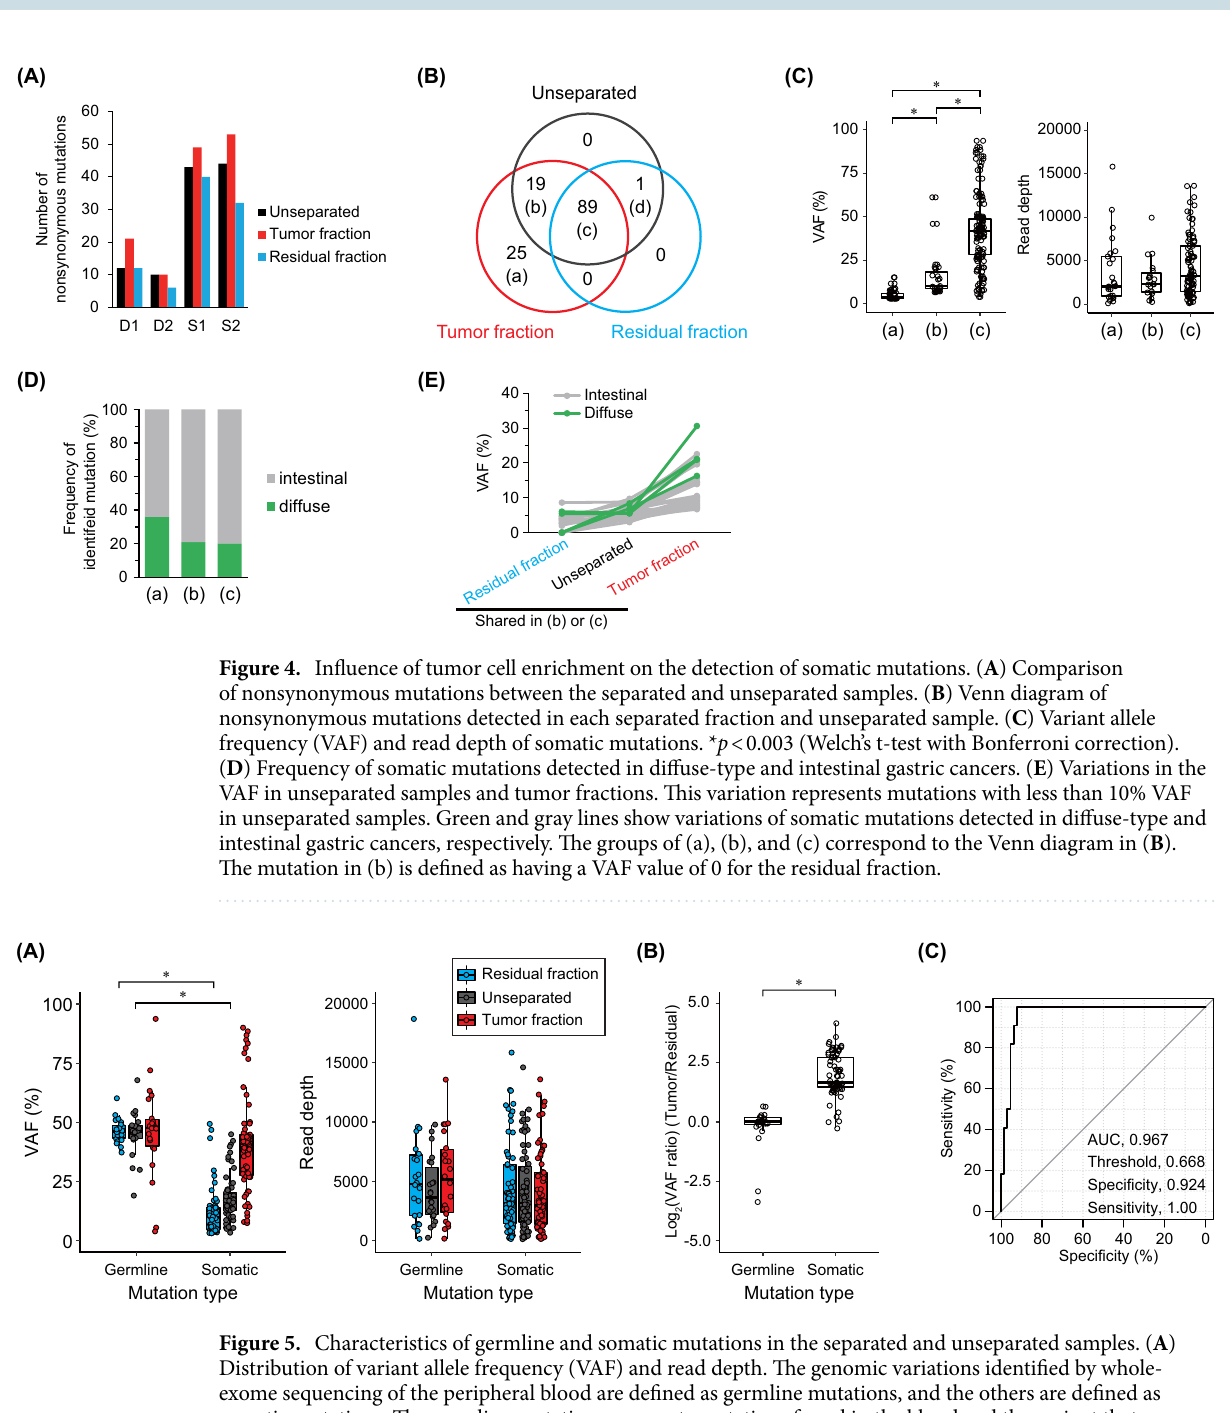
tumor content determined using the population analysis and that estimated by a pathologist. This discordance might be resolved by identification of proteins that are less susceptible to tumor heterogeneity and selection of antibodies against them. The thickness of the FFPE tissue section used in clinical targeted sequencing, such as Foundation One or OncoGuide for Japanese cancer genome mutations, is 10 µm 5,7 . However, tissue cell suspensions have been pre- pared from FFPE tissue sections with thickness of 50 µm to maintain the cell shape 13 . We confirmed the quality of DNA extracted from FFPE tissue sections of different thicknesses, and show, for the first time, that the quality